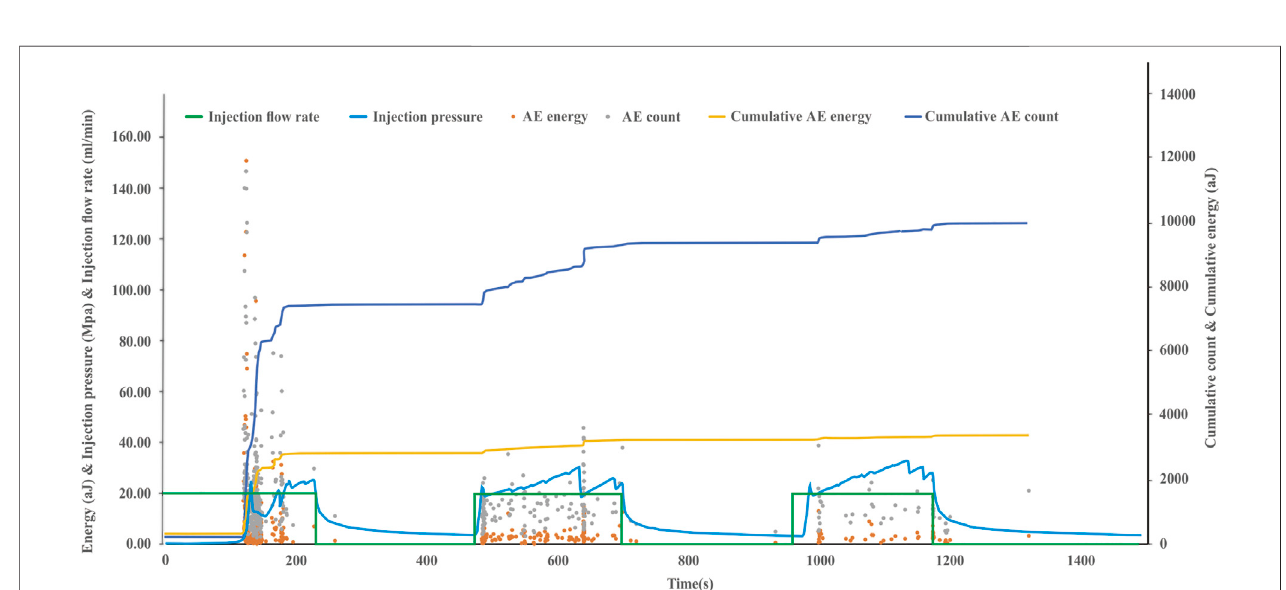
FIGURE 4 | Result of the injection pressure and AE energy and count of